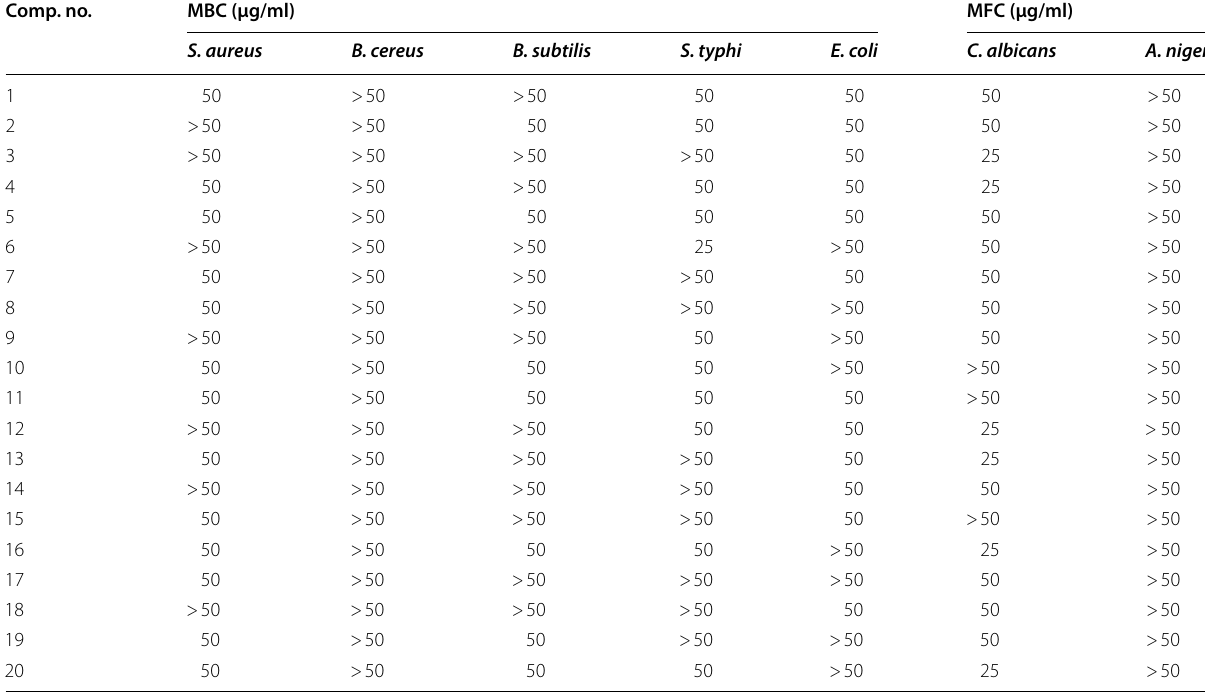
Table 2 MBC/MFC (µg/ml) of 2-(1-benzoyl-1 H -benzo[ d ]imidazole-2-ylthio)-2-ylthio)- N -substituted acetamides Comp. no.